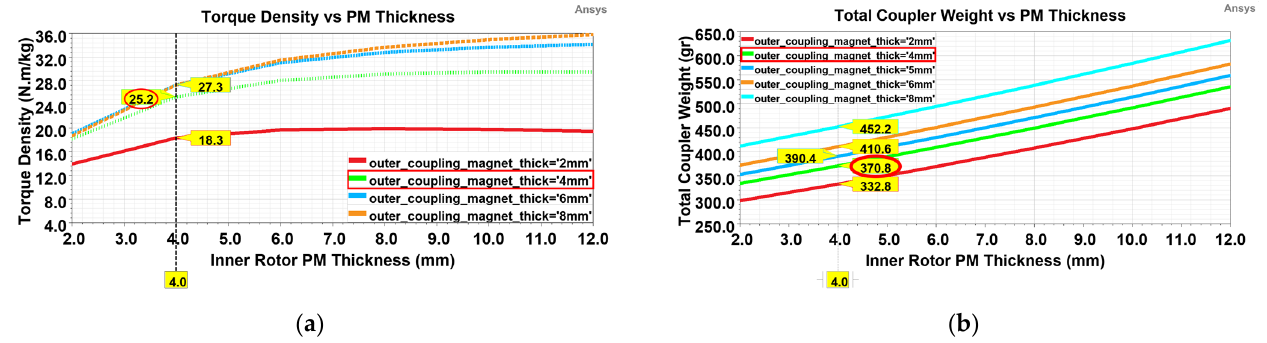
Figure 9. Pullout torque investigation versus: ( a ) Pole number in air gap length; ( b ) Air gap length.